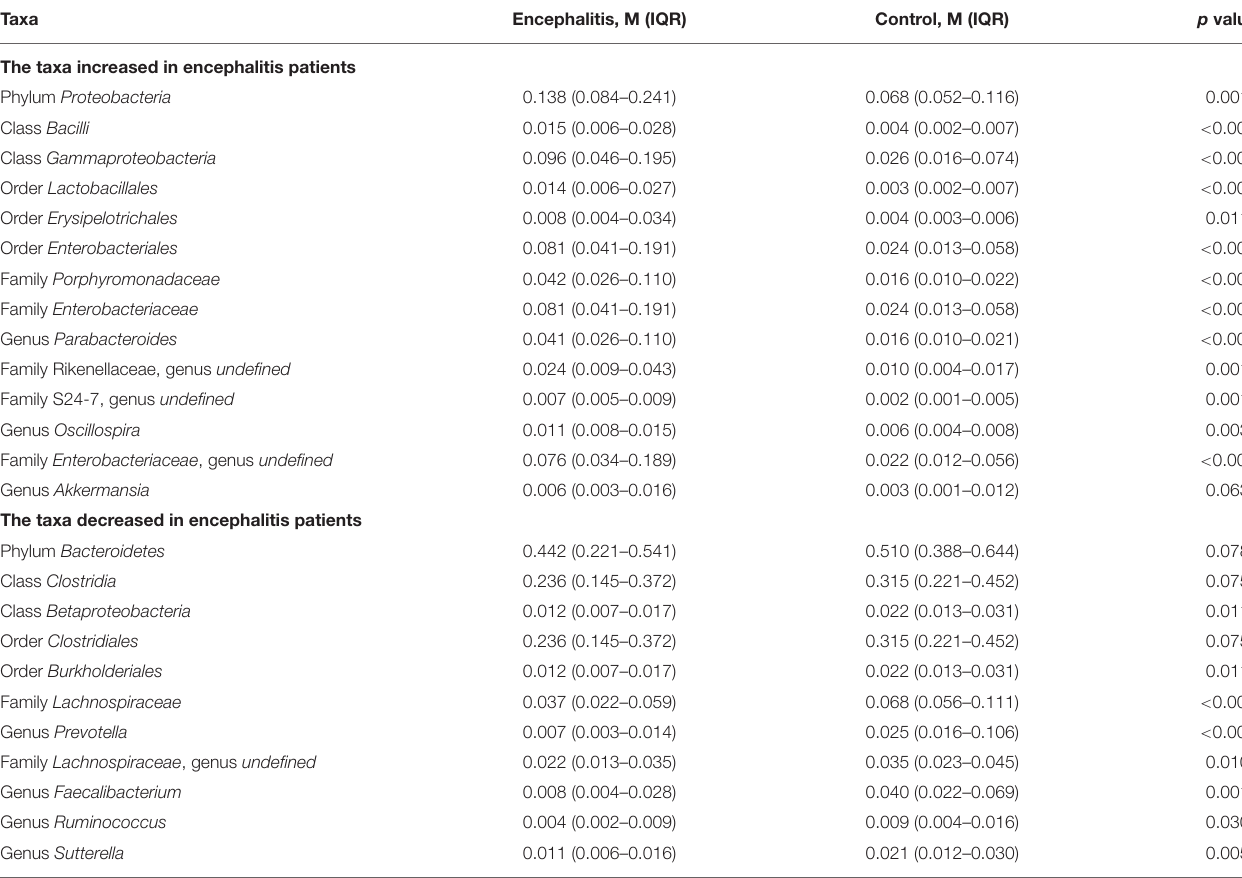
TABLE 2 | Significantly discriminative taxa between the twenty-eight Encephalitis patients and healthy subjects determined by Mann-Whitney U